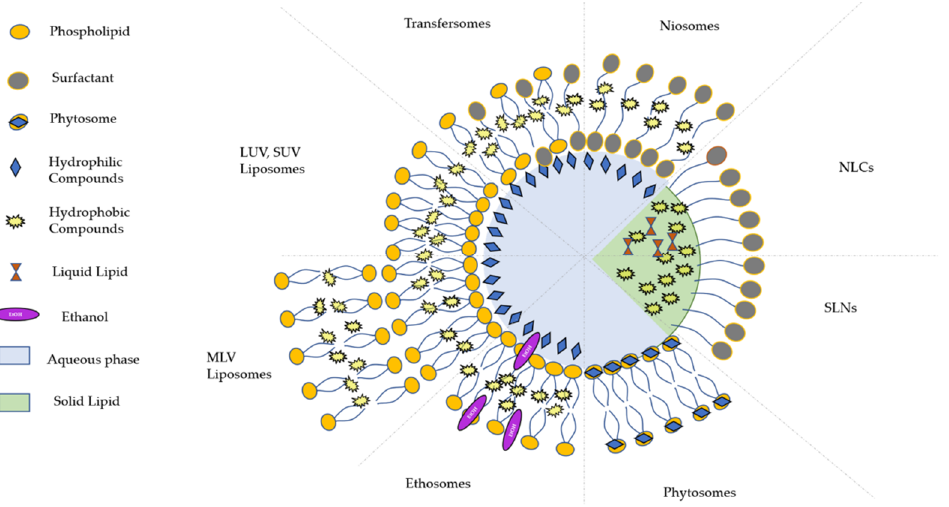
Figure 3. Schematic overview of the different lipid-based delivery systems (abbreviations: MLV, multilamellar vesicles; LUV, large unilamellar vesicles; SUV, small unilamellar vesicles; NLC, nanostructured lipid carriers; SLN, solid lipid nanoparticles).